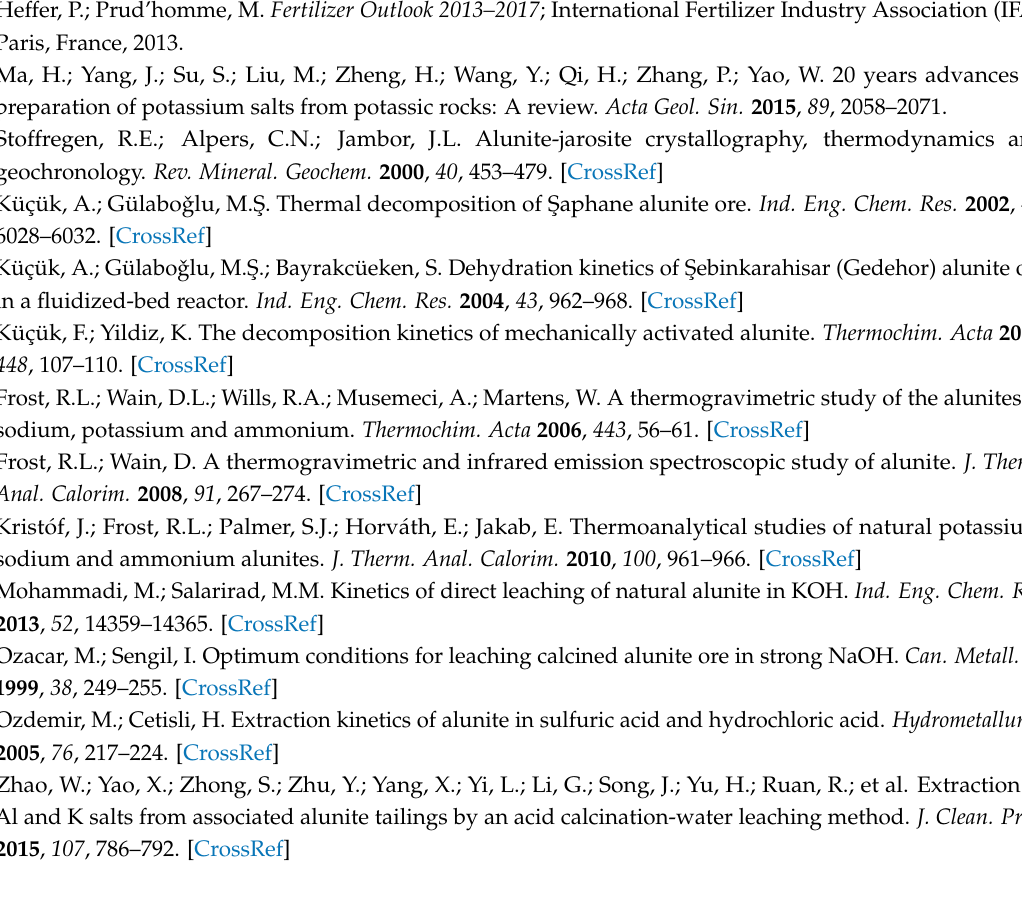
Figure S1: The mineral phase analysis of the alunite ore used in this study, Table S1: Elements analysis of the alunite ore used in this paper (in oxide